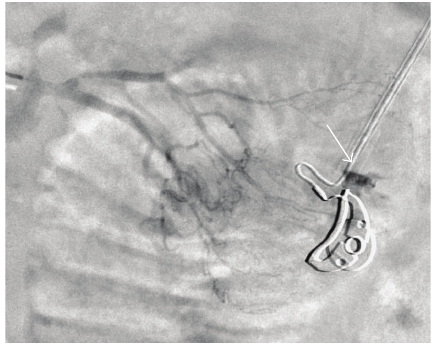
Figure 2: Angiography demonstrating active bleeding (arrow) in one of the branchs of the jejunal arteries.